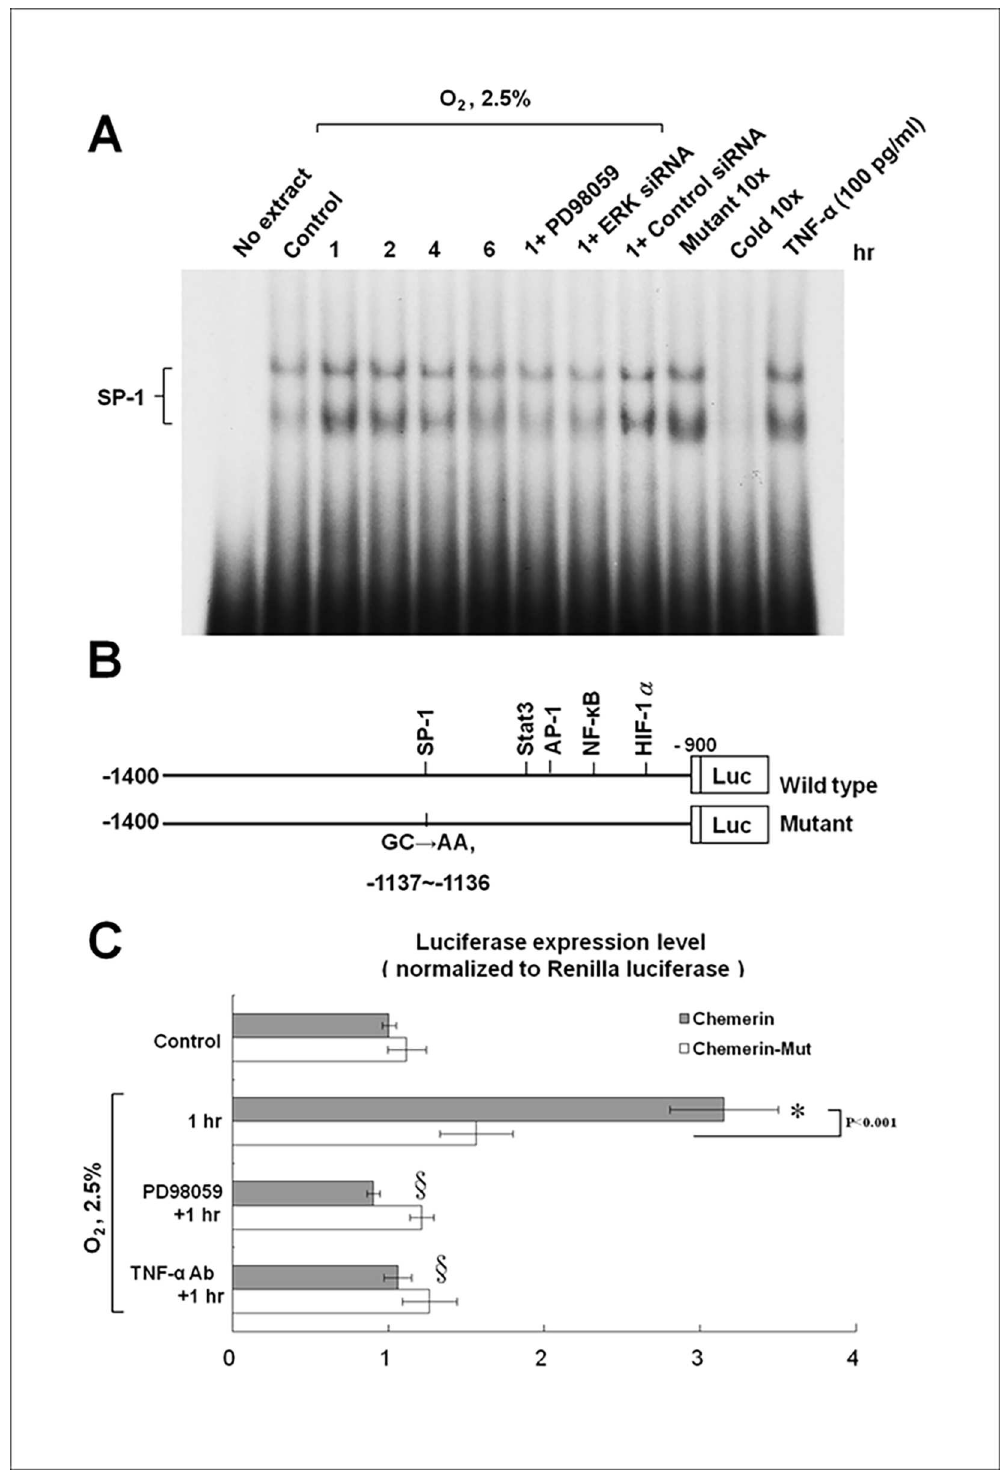
Fig 4. Binding of chemerin promoter with the SP1 transcription factor and transcriptional activity of the SP1-binding site of the chemerin promoter are increased in hypoxic HCAECs. (A) The electrophoretic mobility shift assay (EMSA) showed an increase in bindingof chemerinpromoter and SP1 in HCAECs during 2.5% O 2 hypoxia. (B and C) The luciferase reporter assay revealed that hypoxia at 2.5% O 2 increasedthe